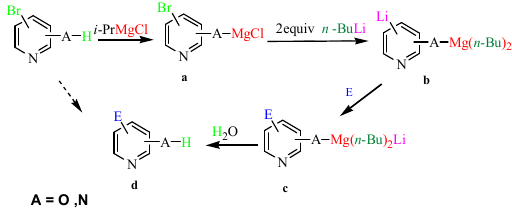
Scheme 3. Proposed mechanism.